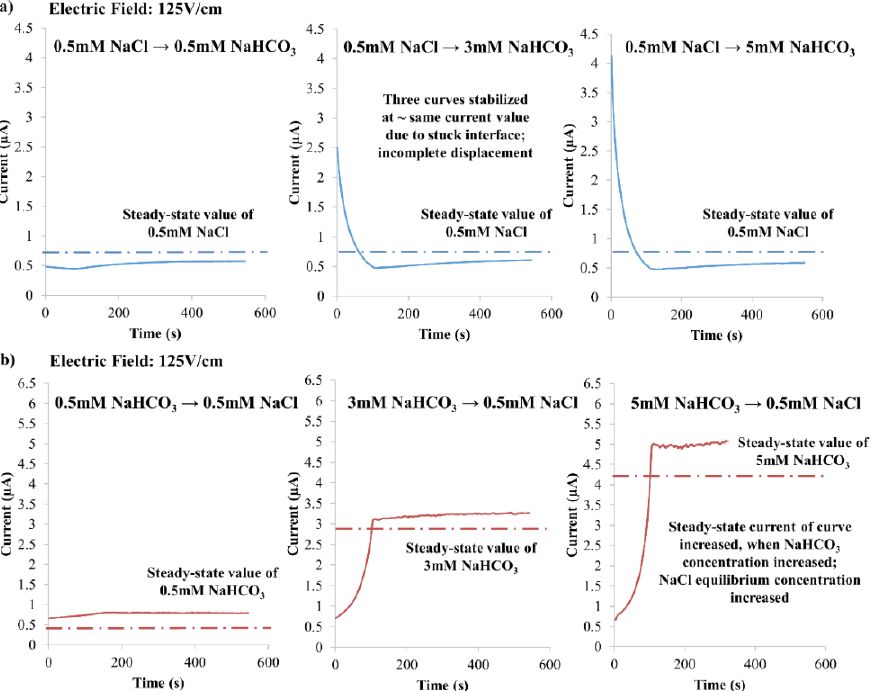
Figure 10. Experimental observations of varying NaHCO 3 concentration, i.e., 0.5 mM, 3 mM and 5 mM, with the NaCl concentration fixed at 0.5 mM and an electric field of 125 V · cm − 1 . ( a ) NaCl → NaHCO 3 (arrow indicates EOF direction), and ( b ) NaHCO 3 →